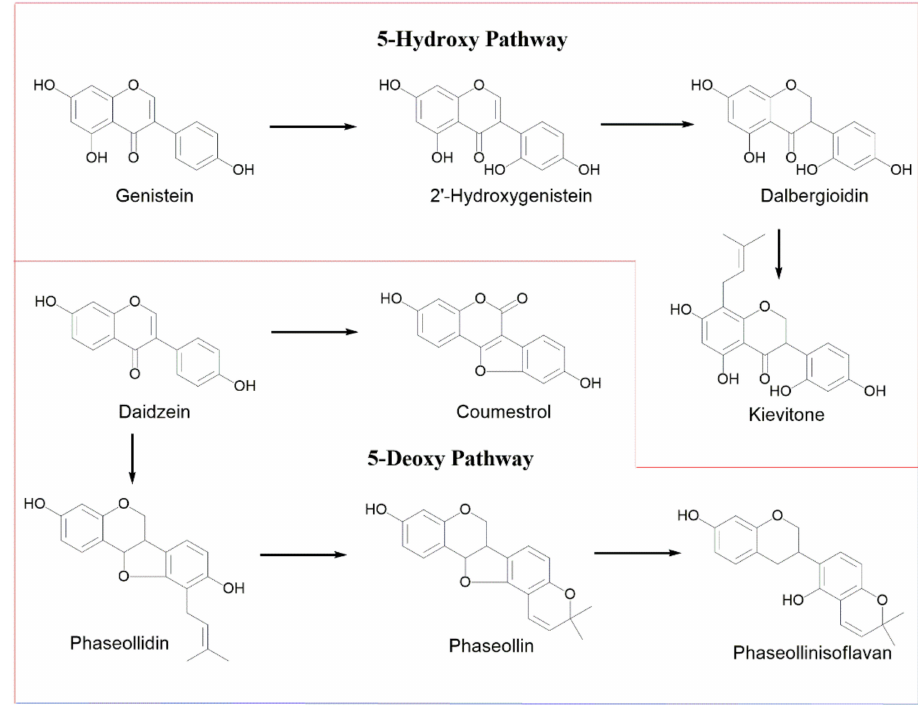
Figure 2. Biosynthetic pathways of isoflavonoid phytoalexins in common bean ( P. vulgaris